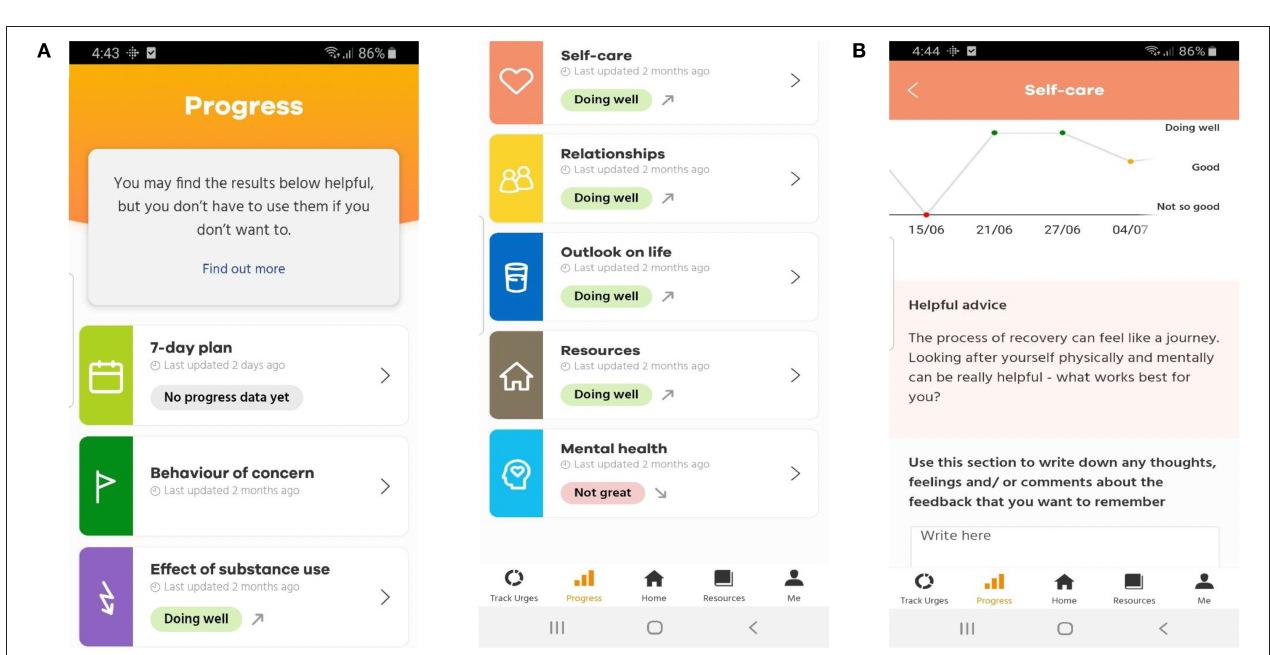
FIGURE 5 | (A) Overall progress screen and (B) Progress screen for the individual domain of “self-care”.